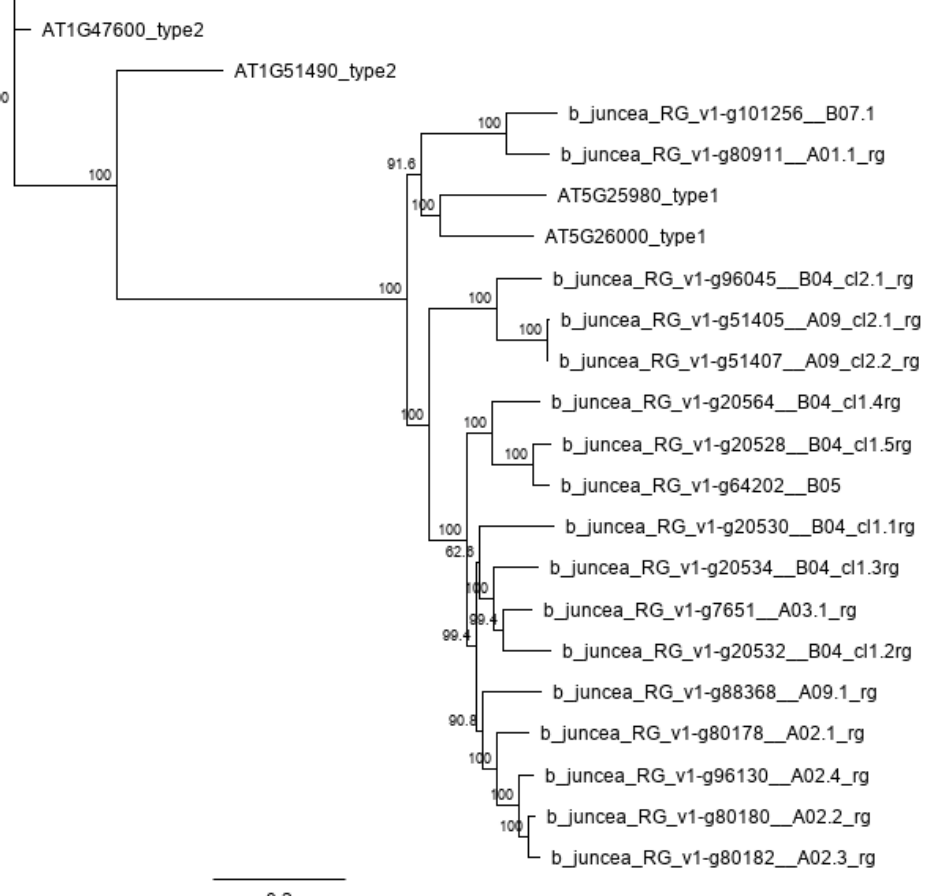
Figure 2. Phylogeny of 17 type-I myrosinase genes in Brassica juncea .